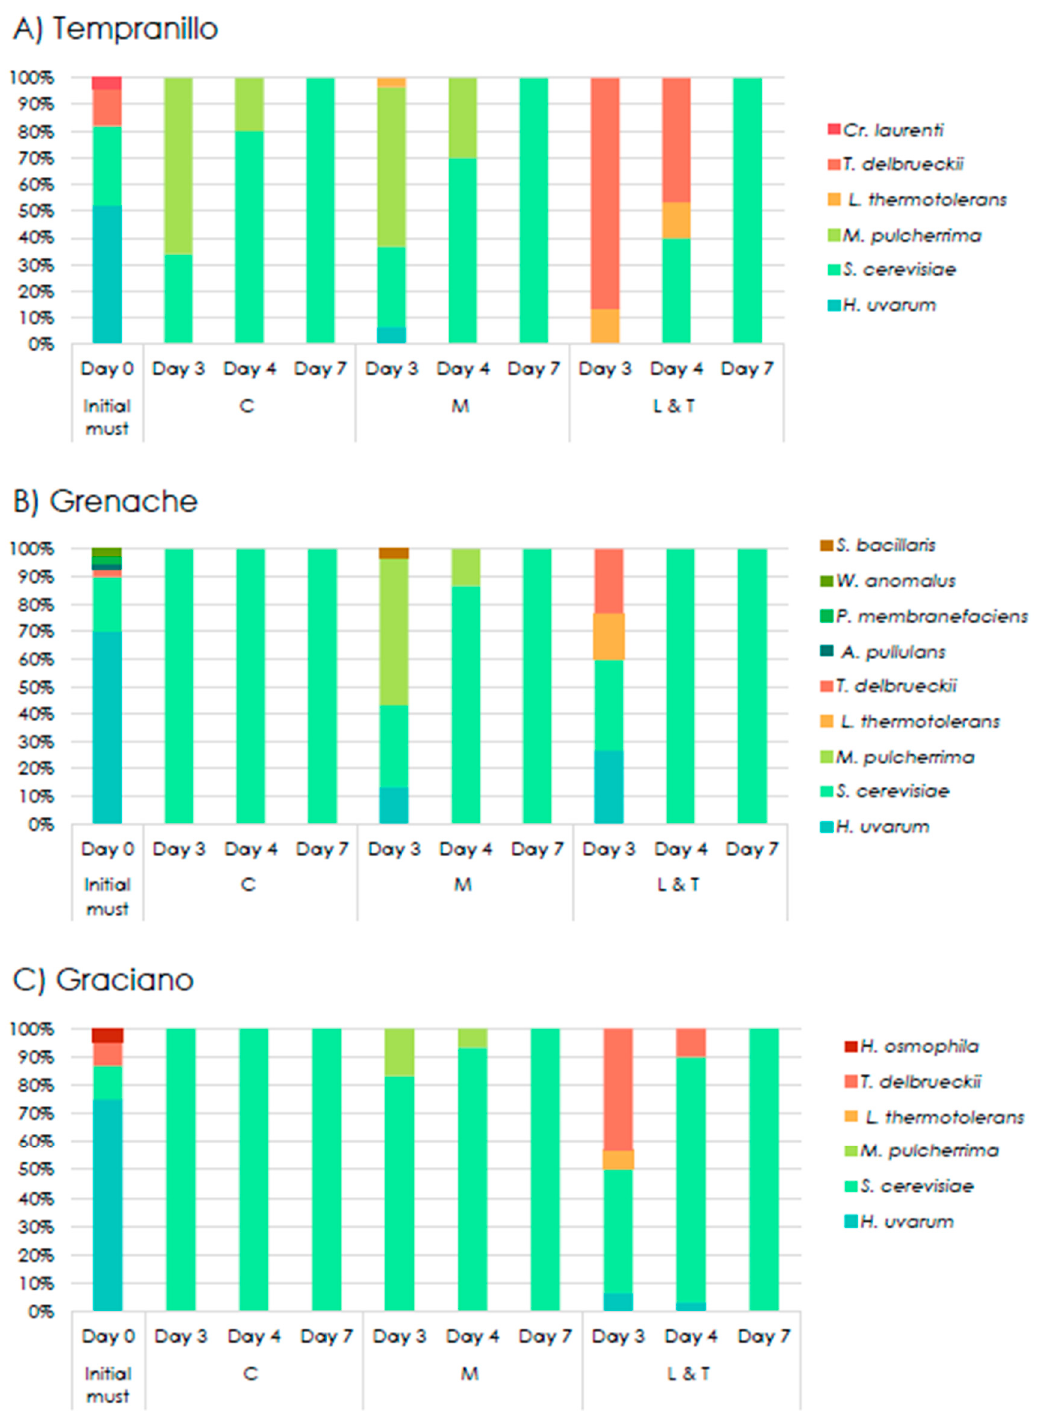
Figure 2. Percentage of yeast species in ( A )Tempranillo, ( B ) Grenache and ( C ) Graciano, initial must (day 0), and control (C) samples and samples early inoculated with M. pulcherrima (M) and with a mix of L. thermotolerans and T. delbrueckii (L&T) during days 3, 4 and 7.